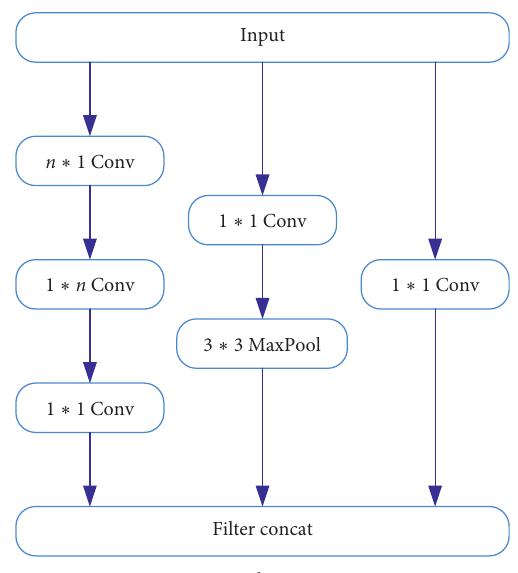
Figure 1: Improved inception structure.